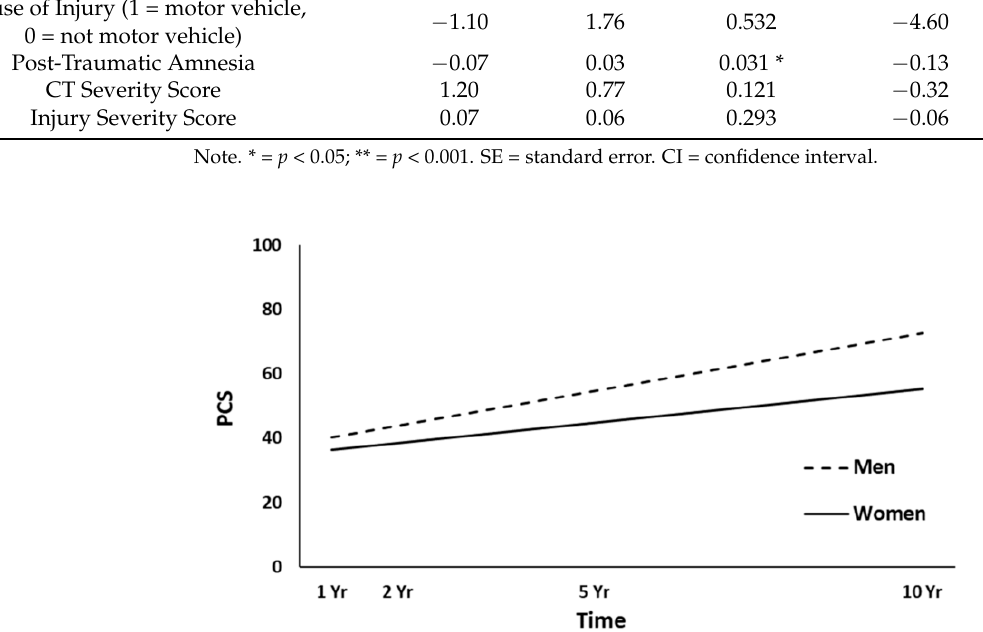
Figure 3. Main effect of employment at admission on the physical health (PCS) trajectories. yr, year.